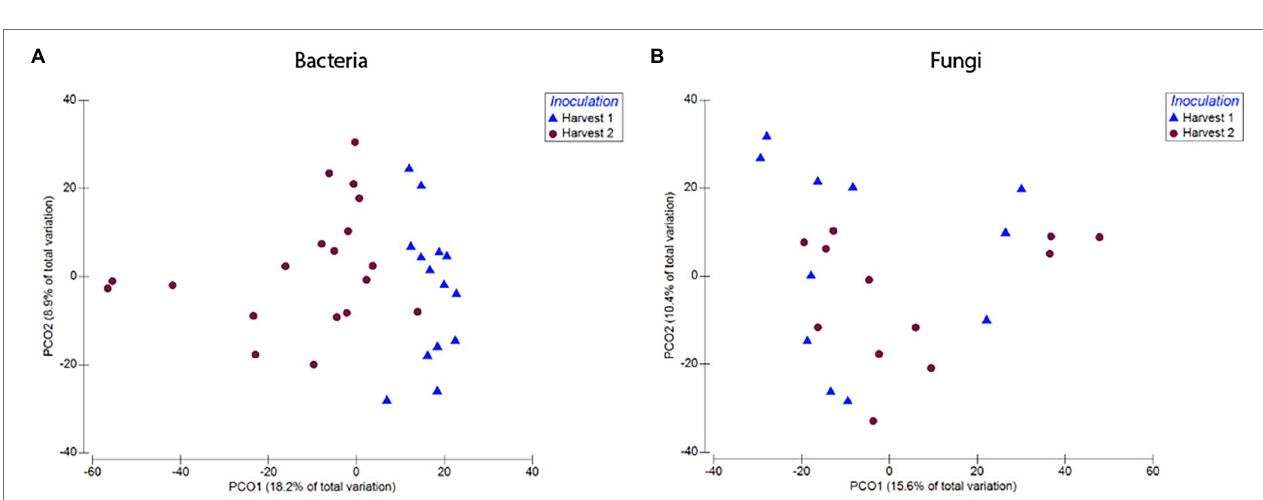
FIGURE 3 | Alpha diversity measures of observed species richness in bacterial (A) and fungal (B) communities in roots harvested prior to (Harvest 1), or 2 weeks after (Harvest 2) exposure to soil. Each dot represents a sample. Soil exposure to an un-colonized root led to a significant increase in bacterial ( t = − 4.29, p = 0.0001) but not fungal ( t = 1.15, p = 0.26) richness. *** indicates p < 0.001.